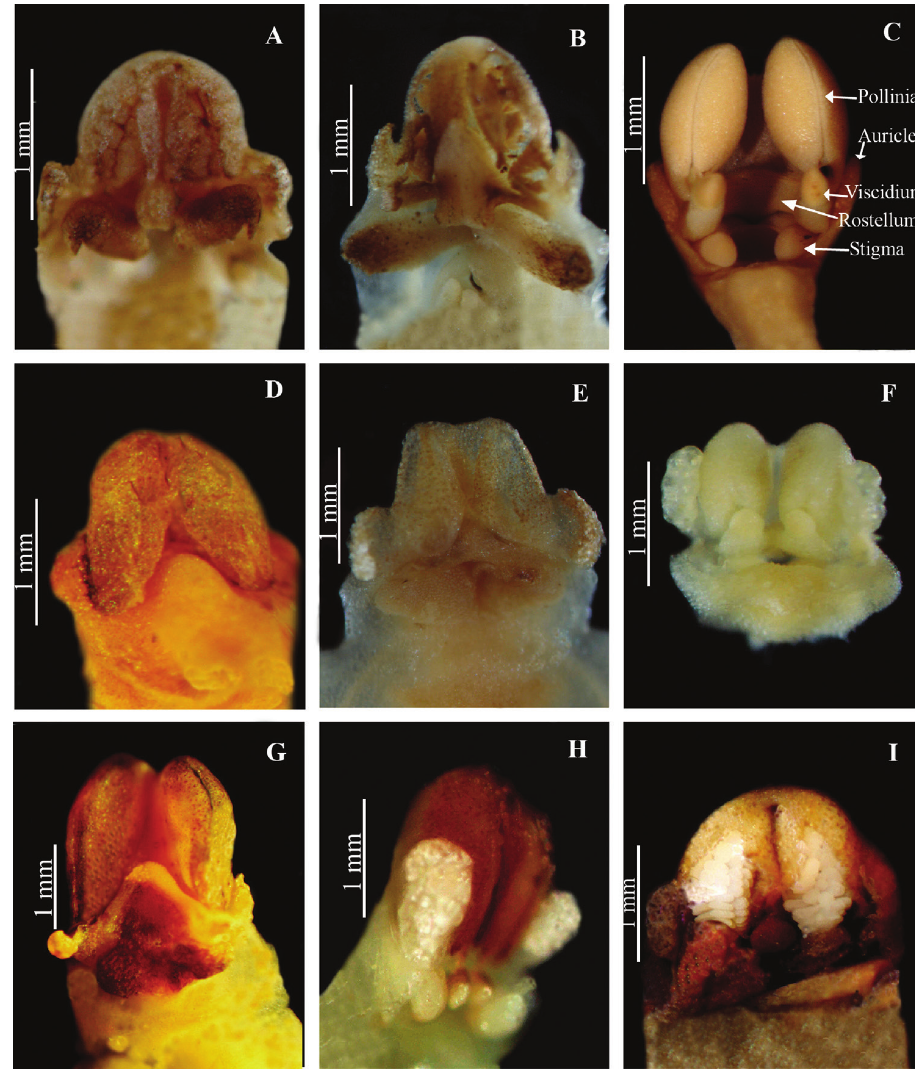
Figure 10. Column structure in Herminium . A H. monorchis B H. josephi C H. latilabre D H. monophyllum E H. kamengense F H. longilobatum F H. himalayanum H H. mannii I H. fallax .